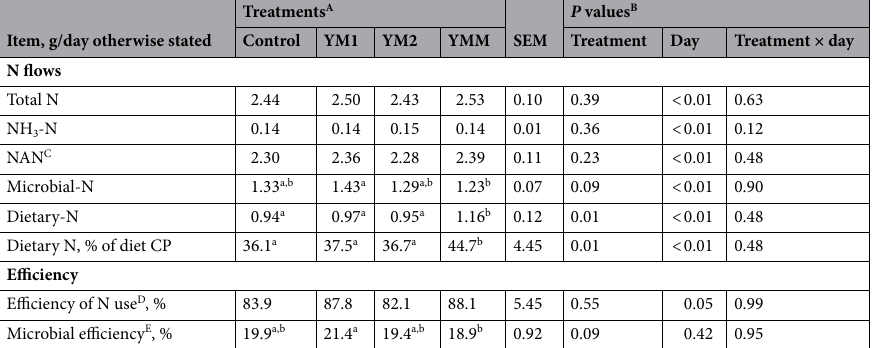
Table 3. Effects of direct-fed microbials (DFM) on ruminal N metabolism in a dual-flow continuous culture system (DM basis). A All treatments had the same basal diet (1 mL of each DFM was applied per day at 1 × 10 8 cfu/mL); treatments were: Control, carrier of additives without DFM; YM1, S. cerevisiae and M. elsdenii strain 1; YM1, S. cerevisiae and M. elsdenii strain 2; YMM, S. cerevisiae and M. elsdenii strain 1 (1/2 dose) and strain 2 (1/2 dose). B Statistical differences were declared at P ≤ 0.05 or as a trend to be different if P > 0.05 and < 0.10. C NAN = Non ammonia nitrogen. D Efficiency of N use = g of microbial N/g of available N (Bach and Stern, 1999). E Bacterial efficiency = g of microbial N/kg of OM truly